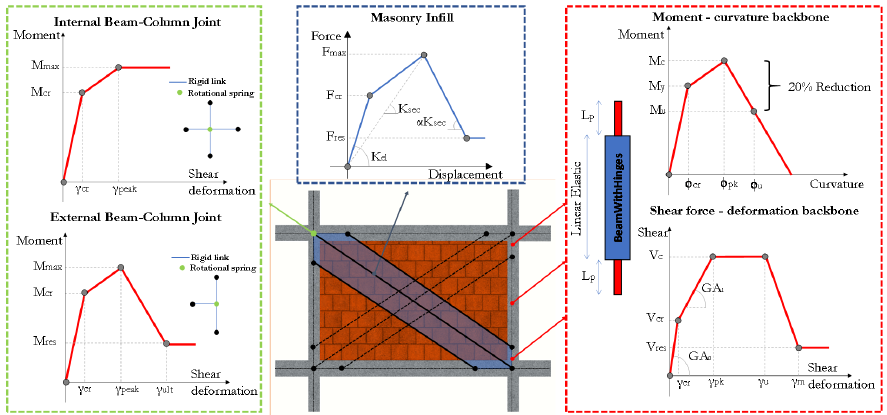
Figure 5. Numerical modelling approach for masonry infill, frame elements and beam-column joints, implemented in OpenSees [60].